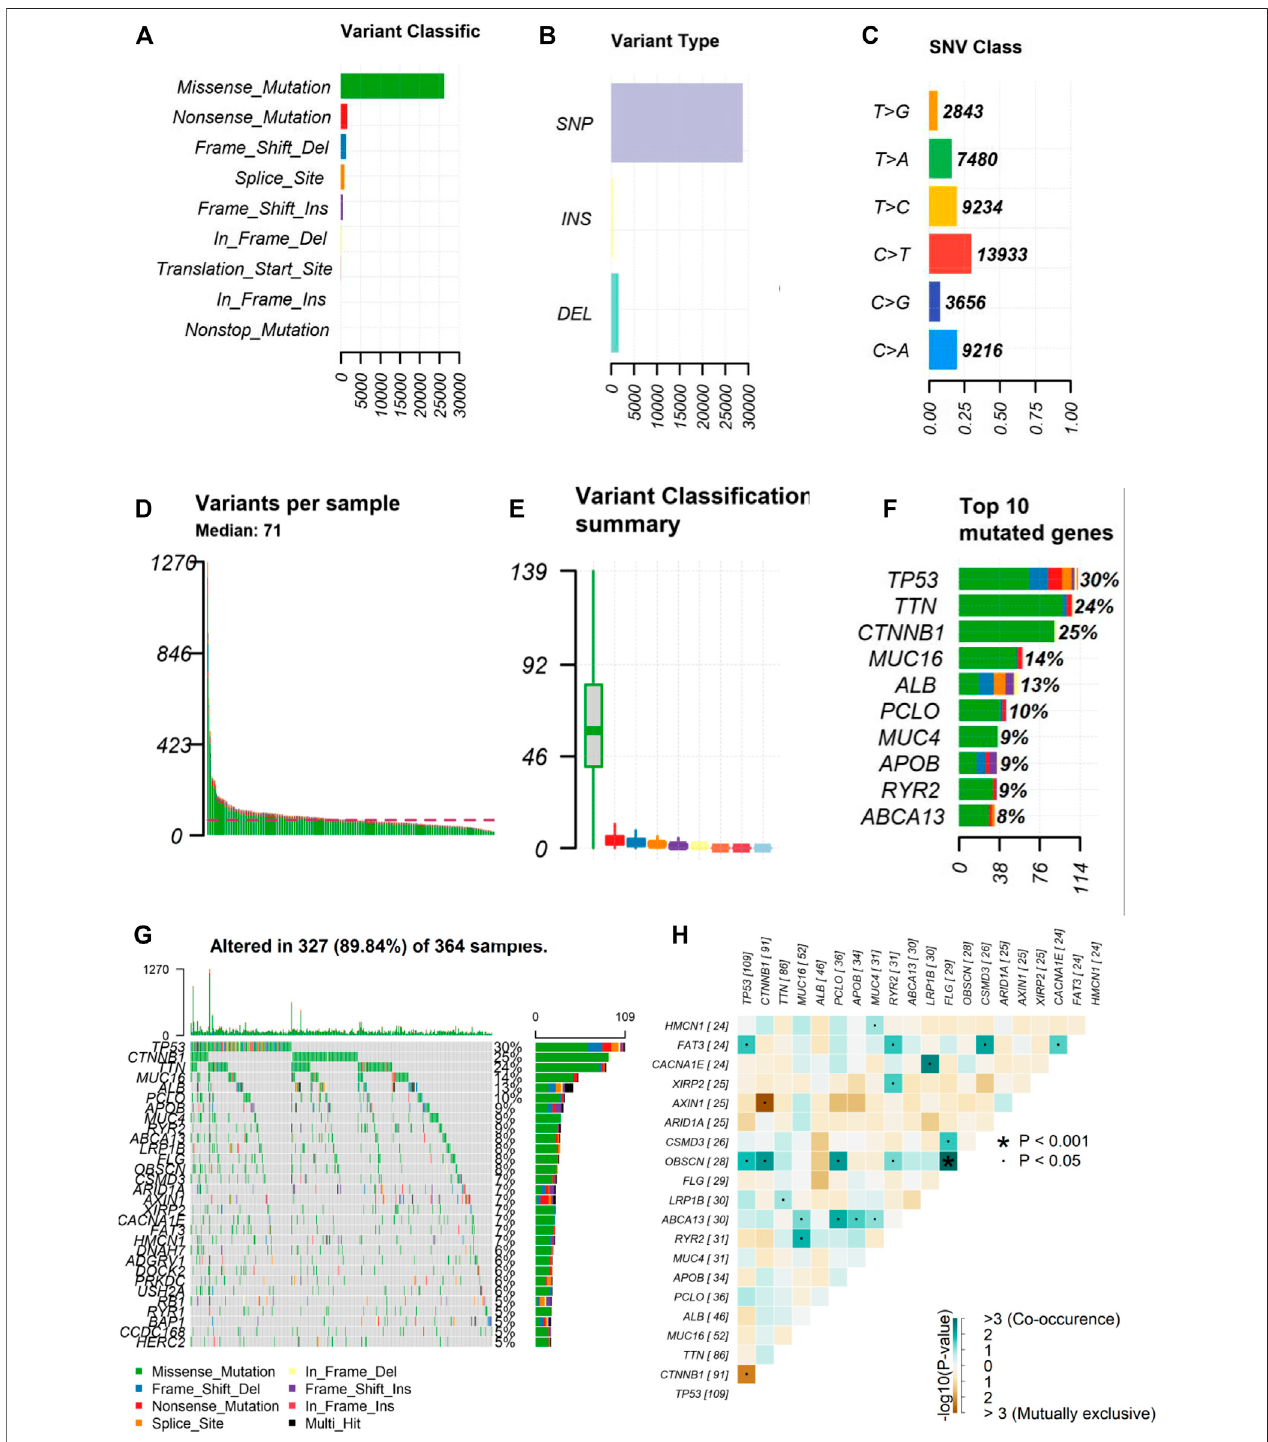
FIGURE 1 | Landscape of frequently gene mutation in HCC. (A – C) Statistical calculations of mutation types based on different categories, where missense mutation, SNP, C > T mutation were the most (D,E) Display of TMB in each HCC sample (F) The top 10mutantgenesin HCC, including TP53, TTN, CTNNB1, MUC16, ALB, PCLO, MUC, APOB, RYR2, ABCA. (G) Landscape of mutation information of each HCC sample in waterfall plot. Each column represents a sample (H) Co-expression of mutant genes in HCC. HCC, hepatocellular carcinoma; SNP, single nucleotide polymorphism. * p < 0.001, _ p < 0.05.